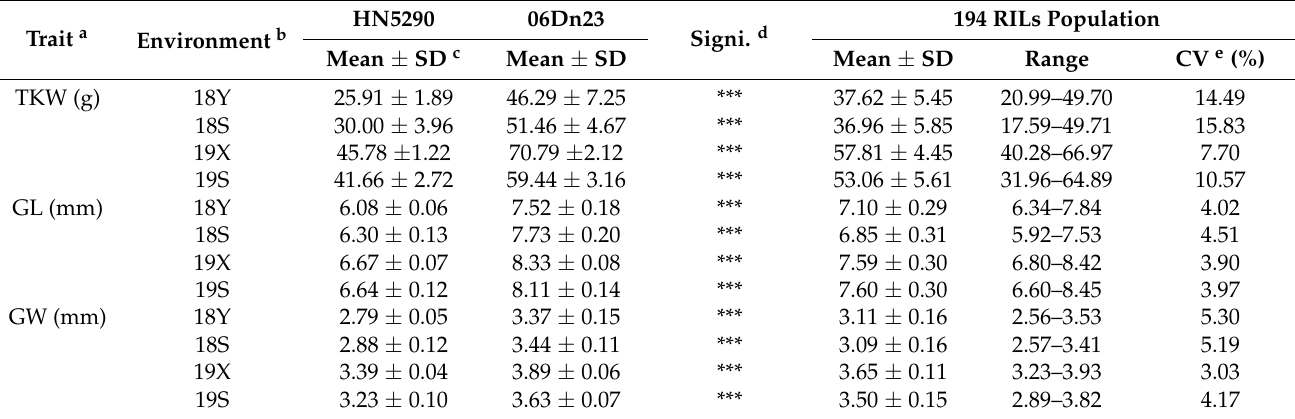
Table 1. Phenotypic performance for thousand kernel weight (TKW), grain length (GL) and grain width (GW) of the F 6 recombinant inbred lines (RILs) and their parents (HN5290 and 06Dn23). Trait a